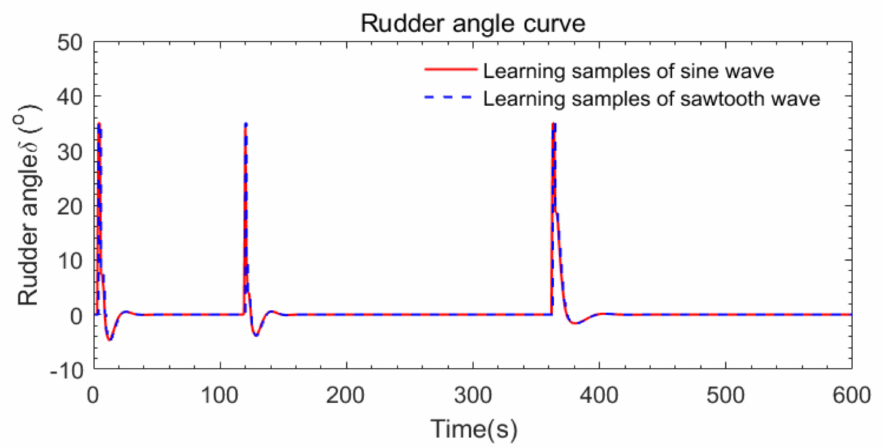
Figure 20. Course-tracking curves in two different learning samples.